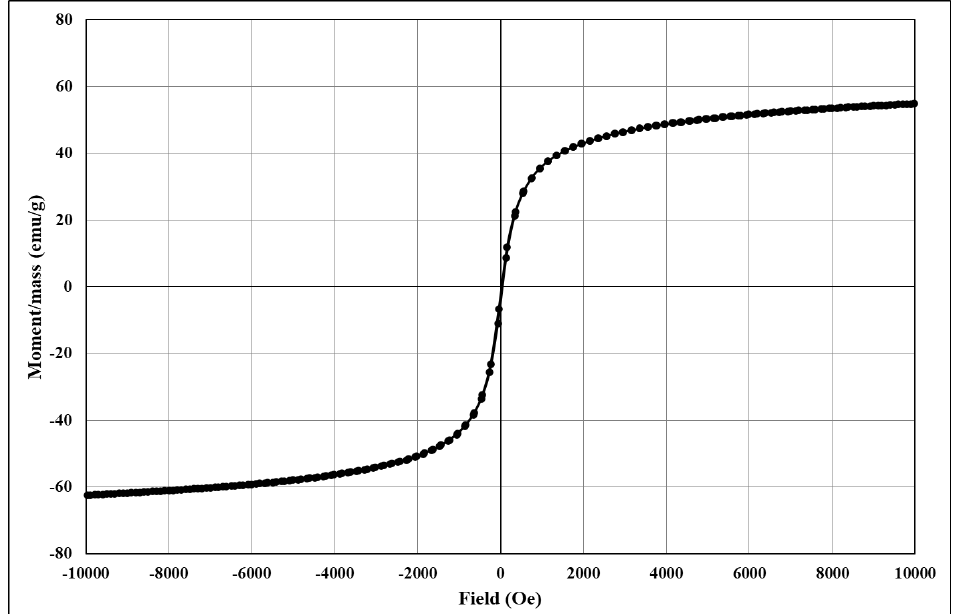
Figure 8. The magnetization/mass ratio for Fe 3 O 4 @citrate@1d.